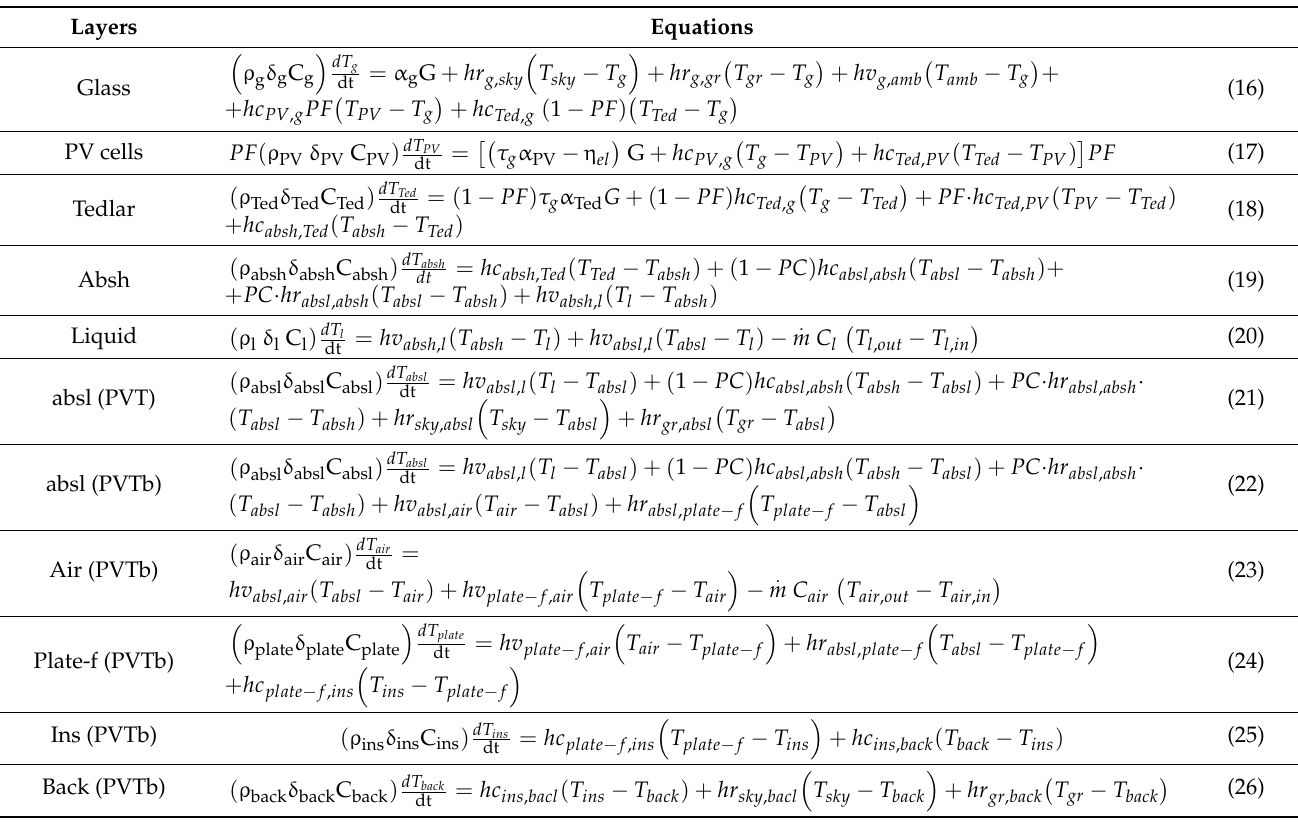
Table 1. Energy balance